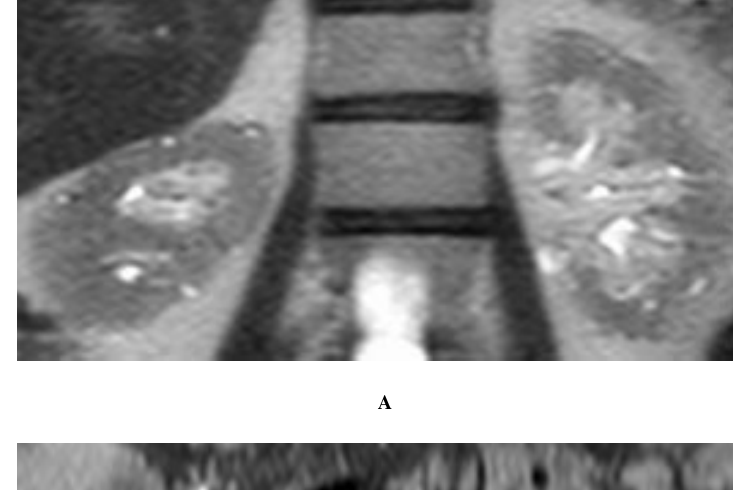
FIGURE. Magnetic resonance (MR) images of the kidney in a 76-year-old woman with chronic kidney disease (CKD) Stage IV associated with previous lithium treatment for over 30 years. (A) Coronal and (B) axial half-Fourier acquisition single-shot turbo spin-echo (HASTE) T2-weighted images (TR/TE, 1000/56; flip angle, 150 degrees) obtained with fat saturation showing multiple hyperintense microcysts in the cortical and medullary